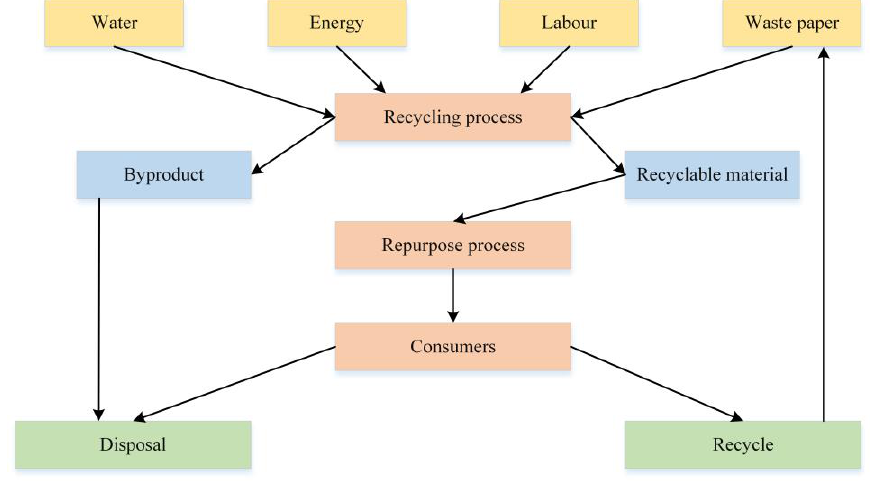
Fig. 2. Scheme for recycling paper and recycling cost